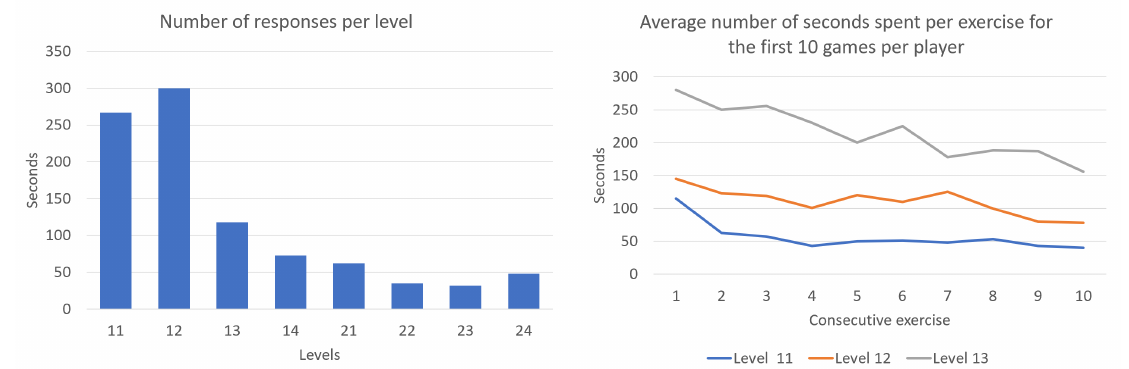
Figure 8. The number of responses (sequences solved) per levels (left), and the average number of seconds spent per exercise in first ten consecutive exercises for first three